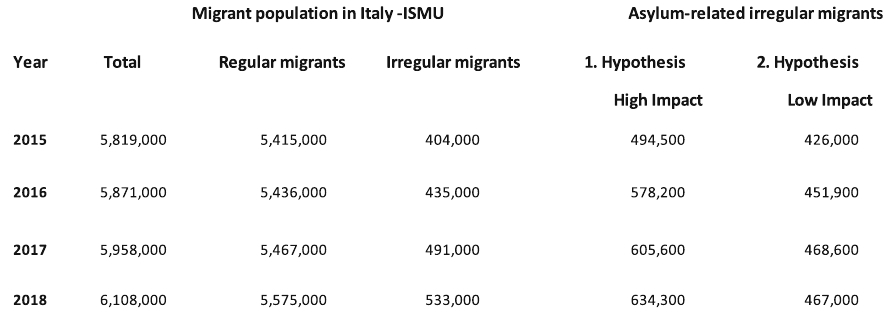
Table 4 Irregular migrants residing in Italy: comparison between